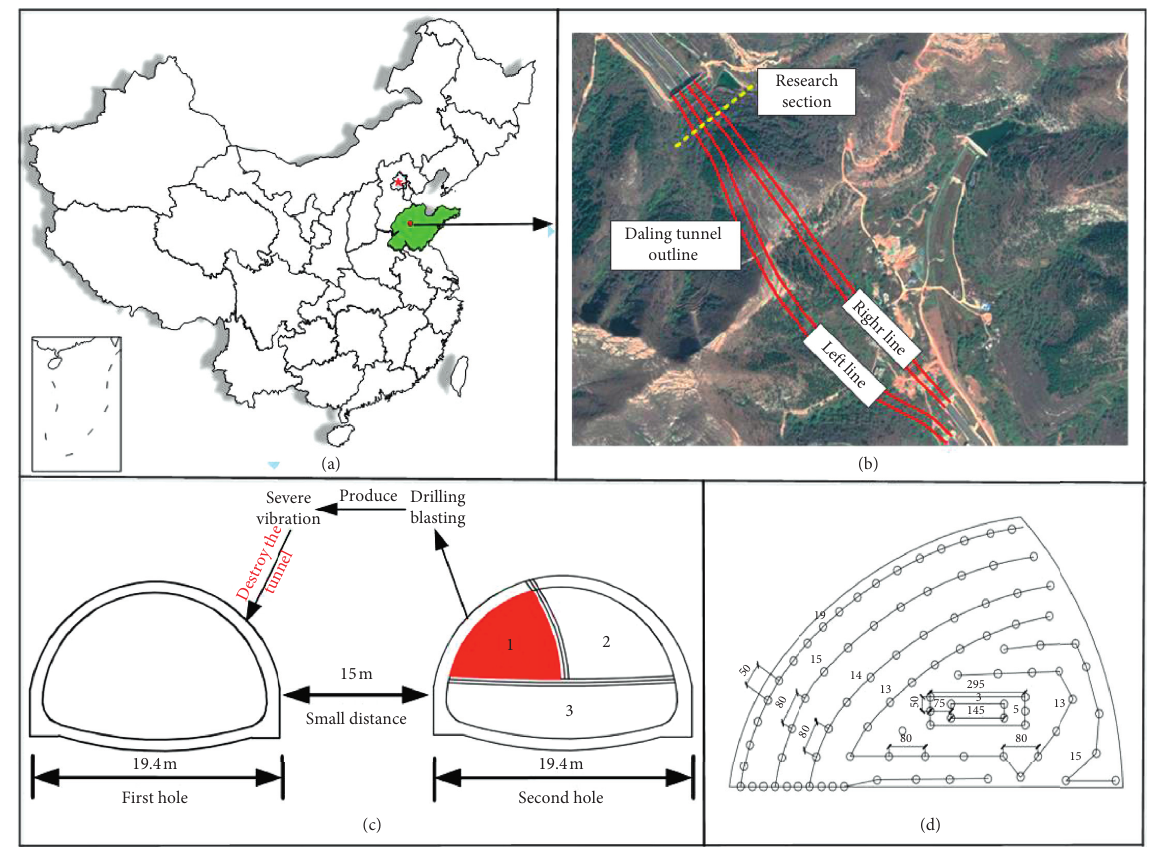
Figure 1: Construction information map of the Daling tunnel. (a) Geographic location of the tunnel. (b) Layout of the tunnel. (c) In- formation on the research cross section. (d) Layout of the blasting holes in the left blasting hole. Table 1: Physical and mechanical parameters of surrounding rock.